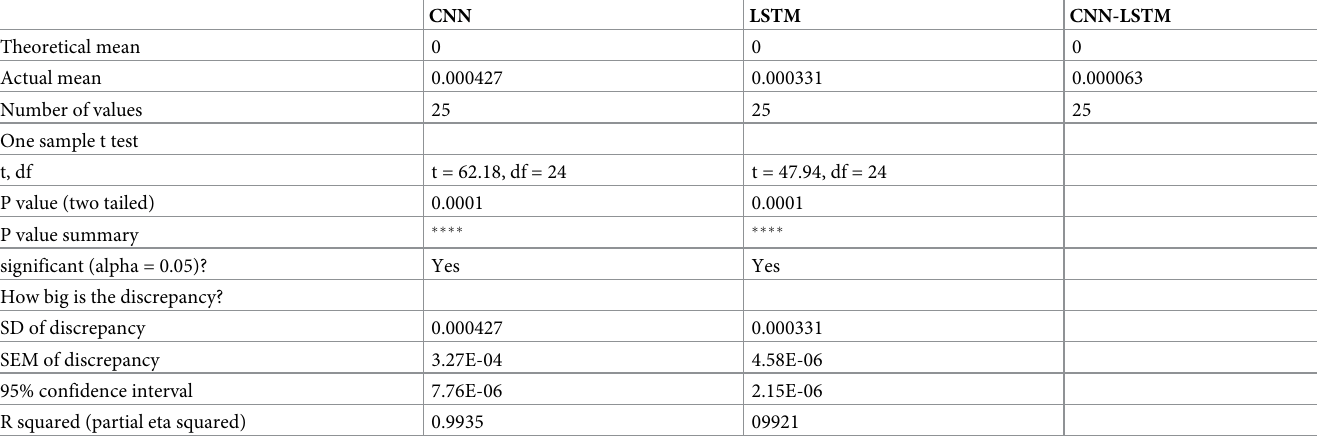
Table 5. Descriptive one-sample t test results of the CNN, LSTM, and proposed CNN-LSTM algorithms.